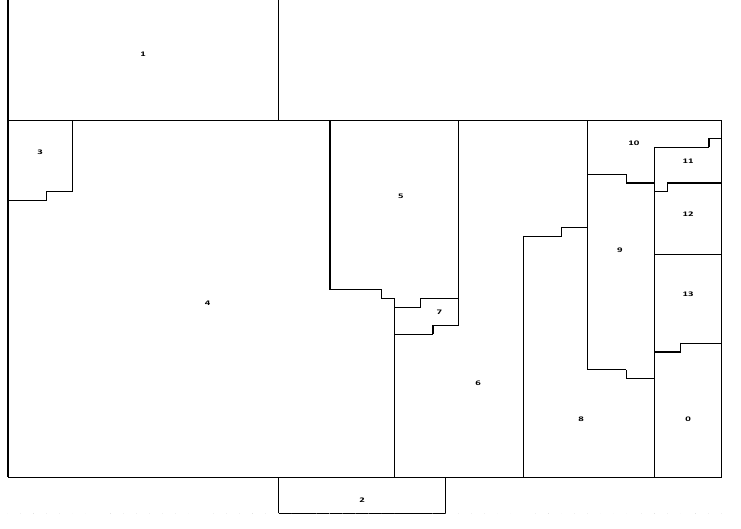
Fig. 9. Layout generated by